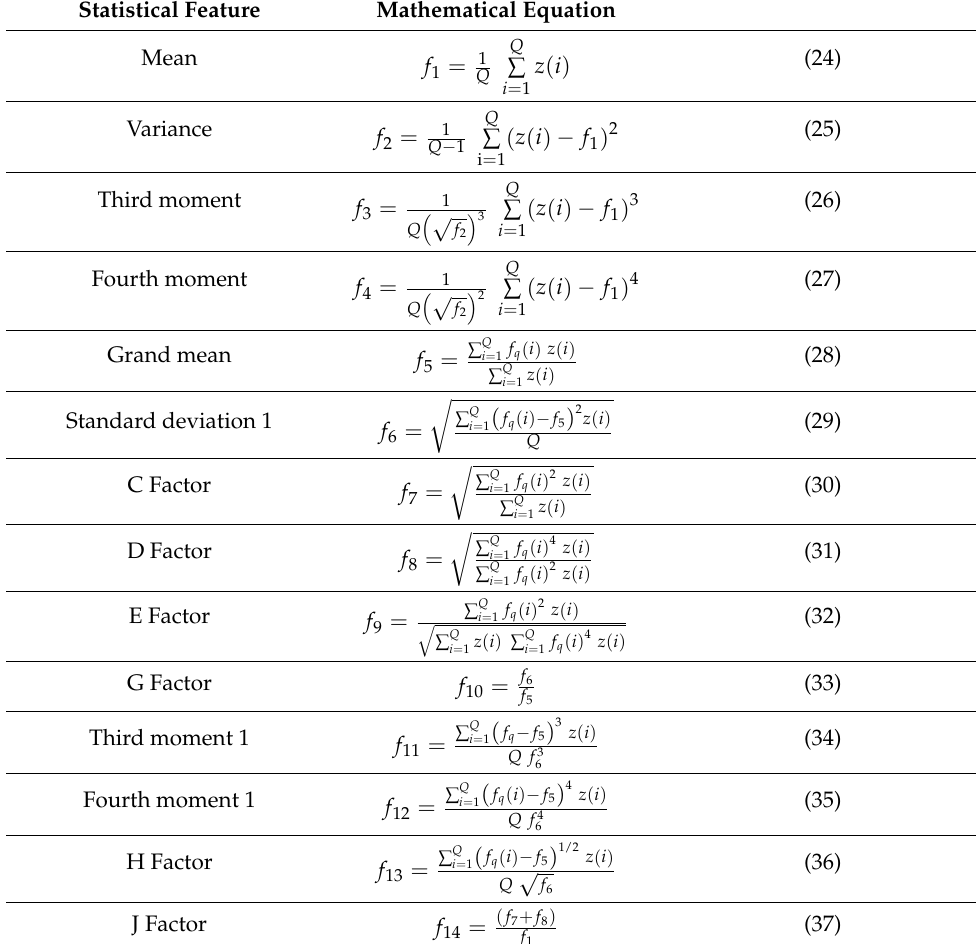
Table 2. Proposed set of statistical time domain features estimated from the frequency spectra during the signal processing in the FD analysis, where each z(i) is a spectrum for i = 1, 2, . . . , Q , and Q is the total number of lines for an estimated spectrum; f q (i) is the frequency value of the i -th spectrum line. Statistical